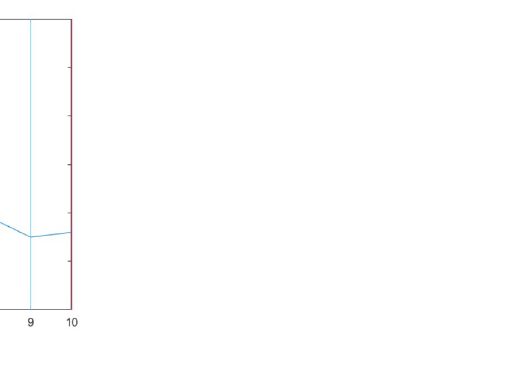
Fig 11. Another example of reduced